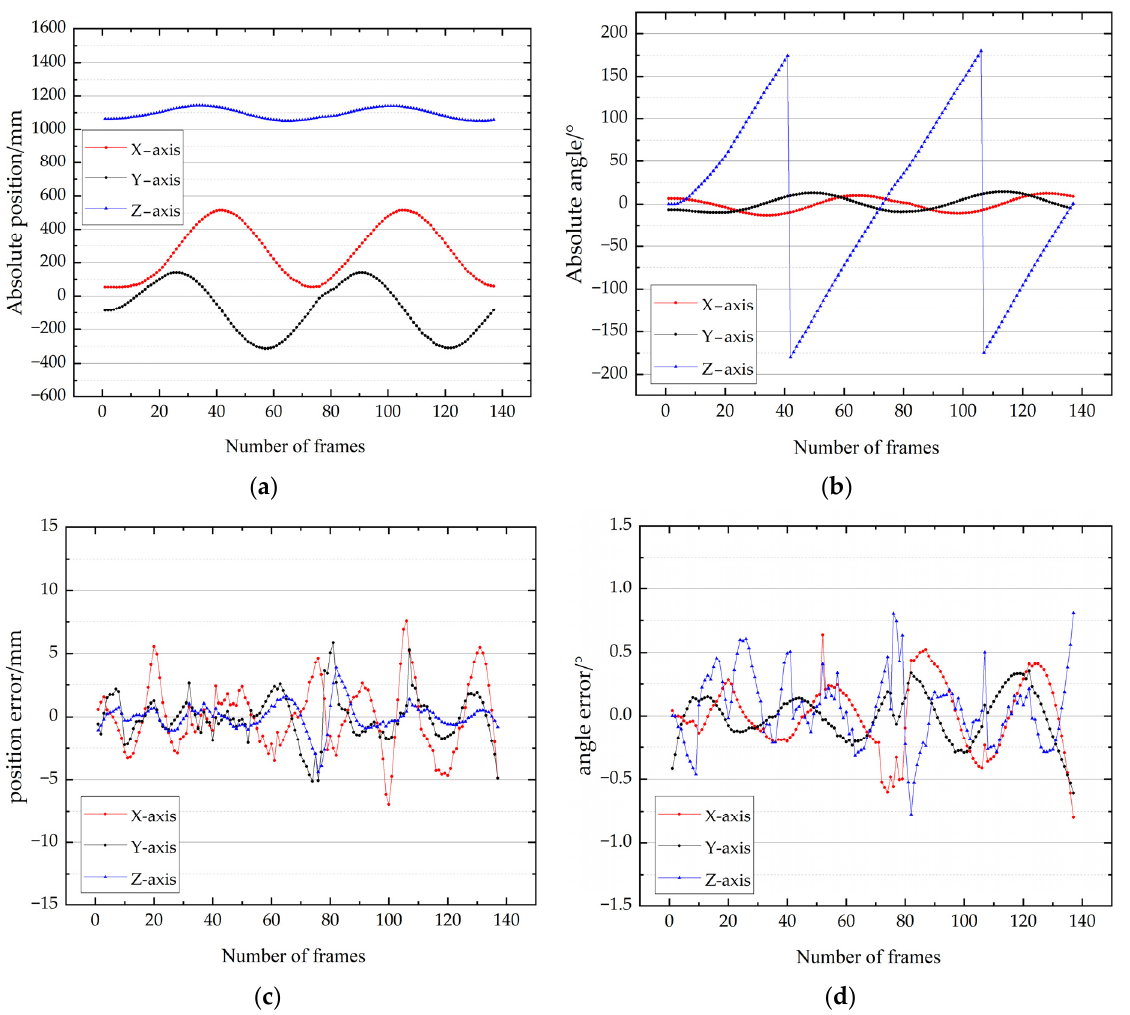
Figure 15. Pose estimation experimental results at low speed: ( a ) absolute position; ( b ) absolute angle; ( c ) error of position; ( d ) error of angle.